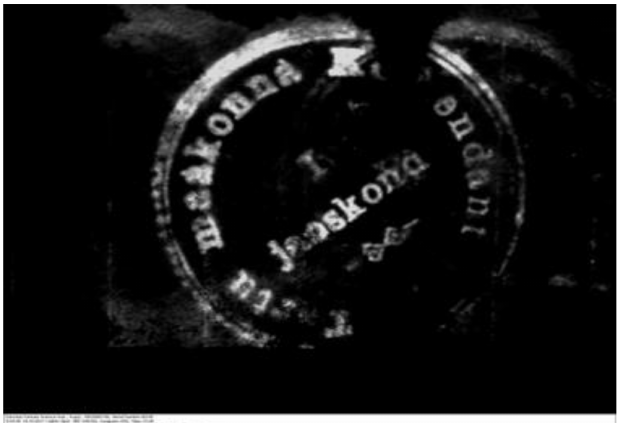
Figure 4. The Stamp impression with the text “Tartu maakonna Komandant” (Commandant of Tartu County).